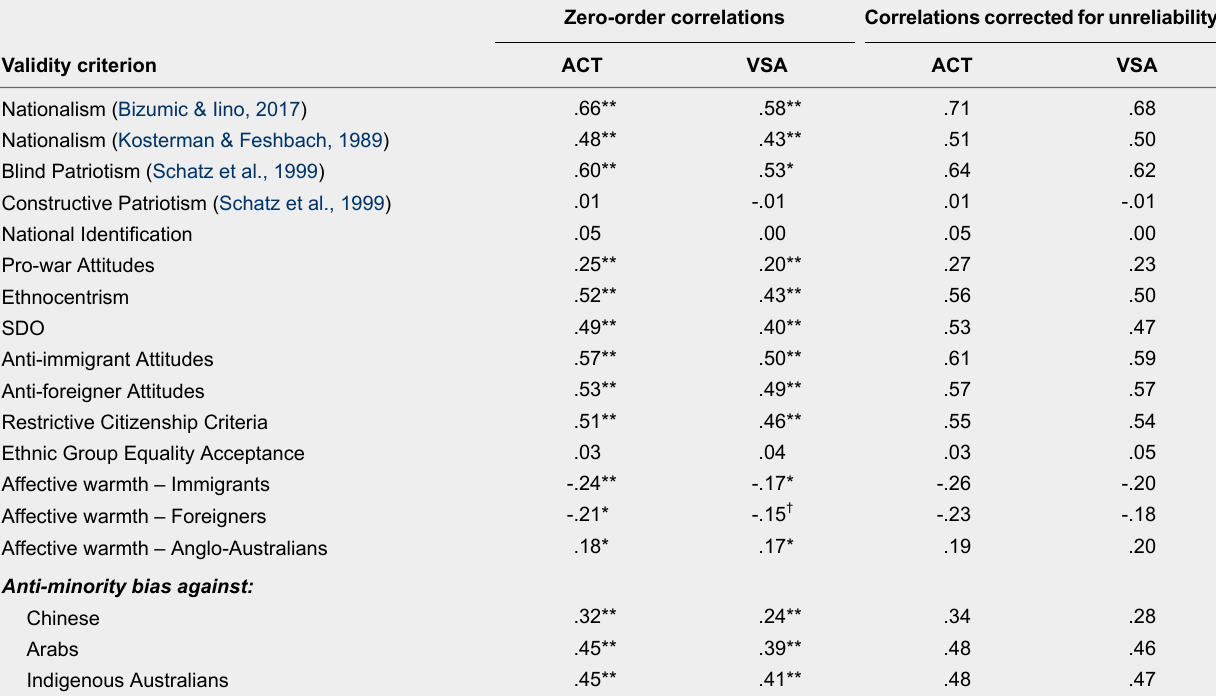
Correlations of the ACT and VSA Scales With Validity Criteria of